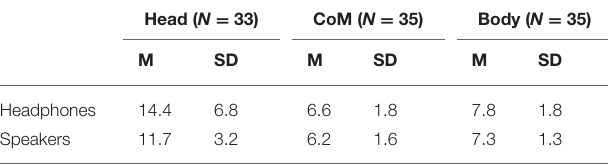
TABLE 5 | Values of the mean and standard deviation of the velocity (mm/s) for each of the motion measures (Head, Center of Mass, Body) during music listening in each